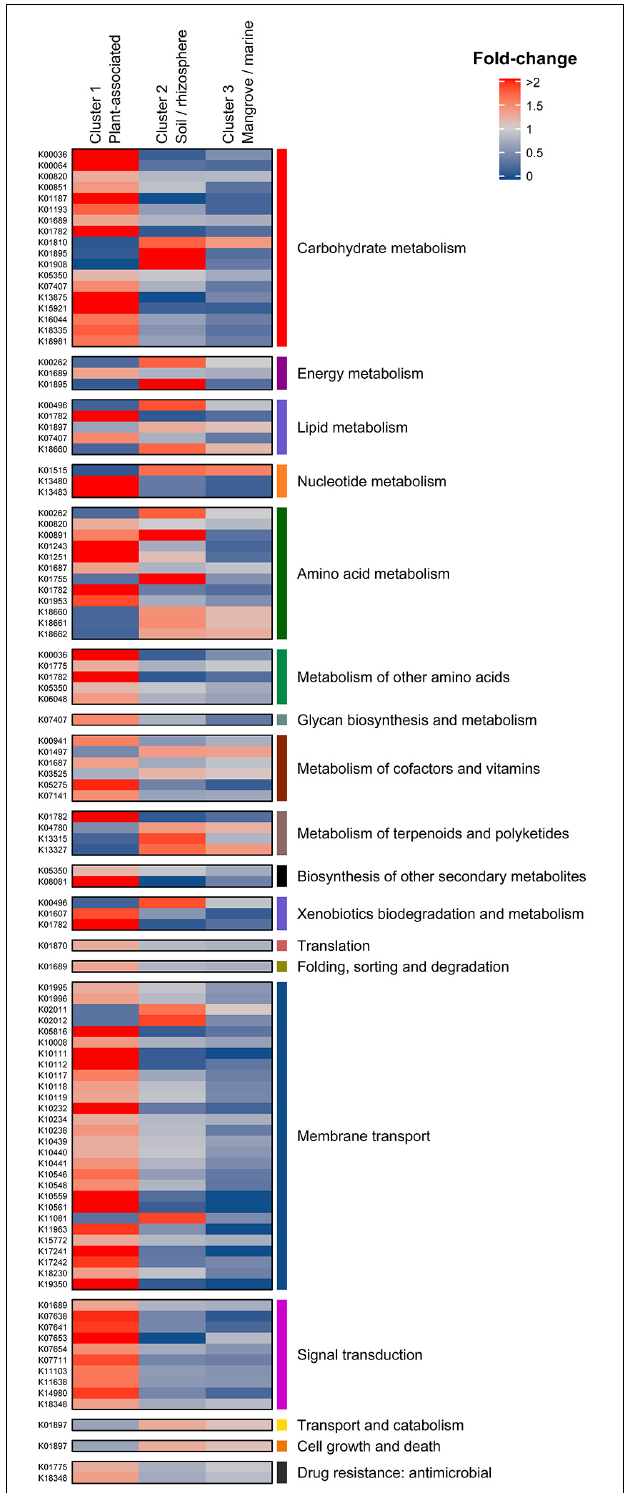
FIGURE 4 | Differential KEGG annotations between Cluster 1 (Plant associated), Cluster 2 (Soil/rhizosphere), and Cluster 3 (Mangrove/marine). Annotations are grouped in their corresponding KEGG categories (first and last